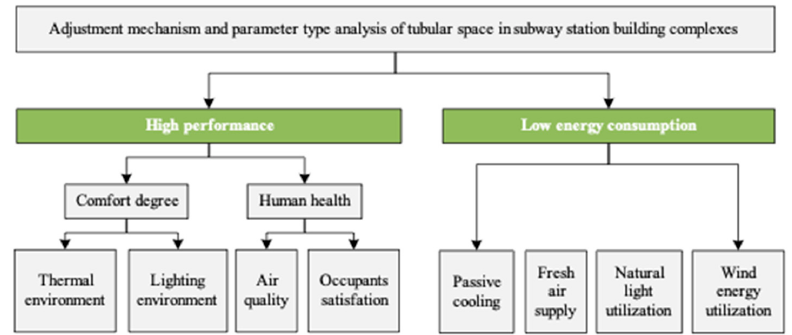
Figure 18. Type analysis of the passive parameters of high performance and low energy consumption- oriented tubular space in subway station building